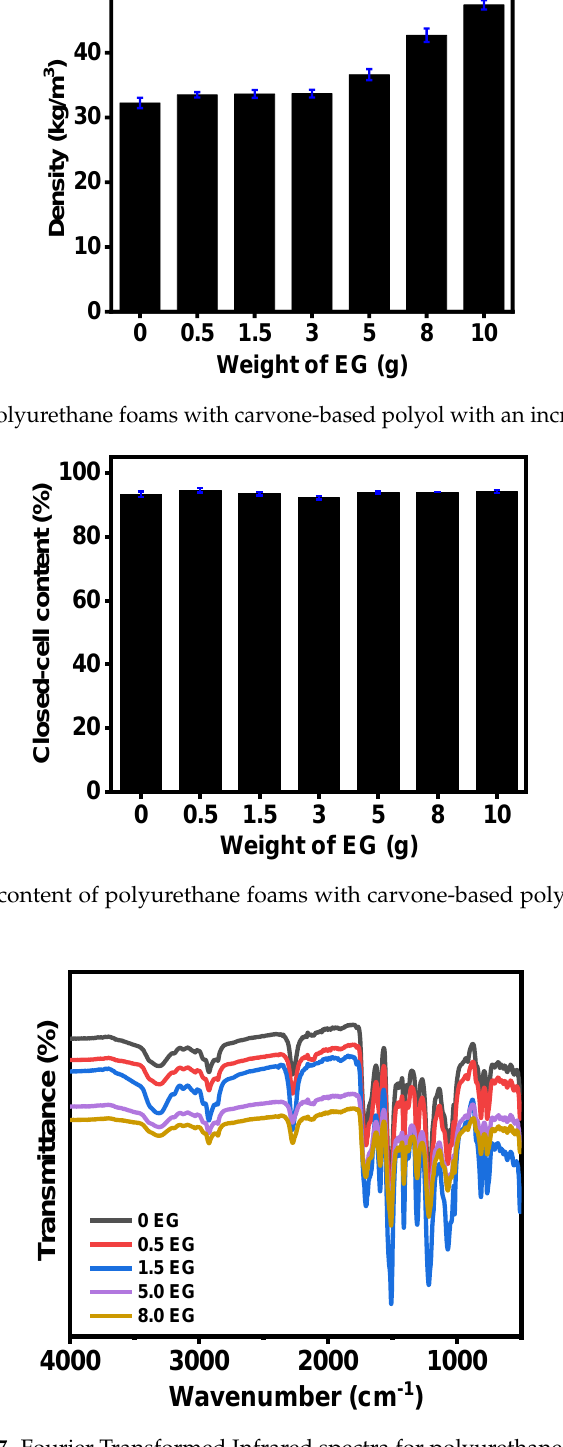
Figure 7. Fourier Transformed Infrared spectra for polyurethane foams.